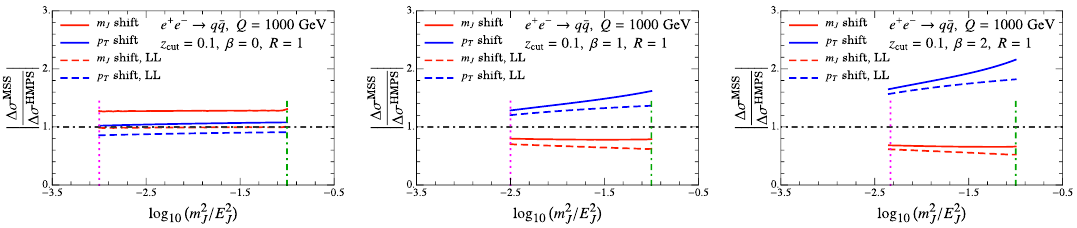
Figure 15 . Comparison of absolute value of the power corrections from our m J shift and p T shift terms (labeled as \HMPS") with the results from ref. [64] (labeled as